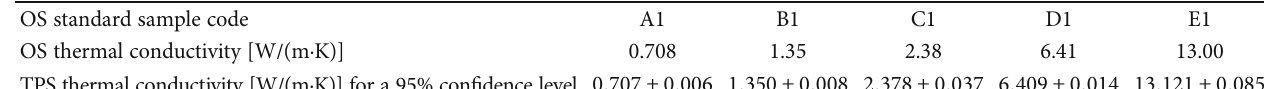
Table 3: Thermal conductivity of OS standard samples measured by